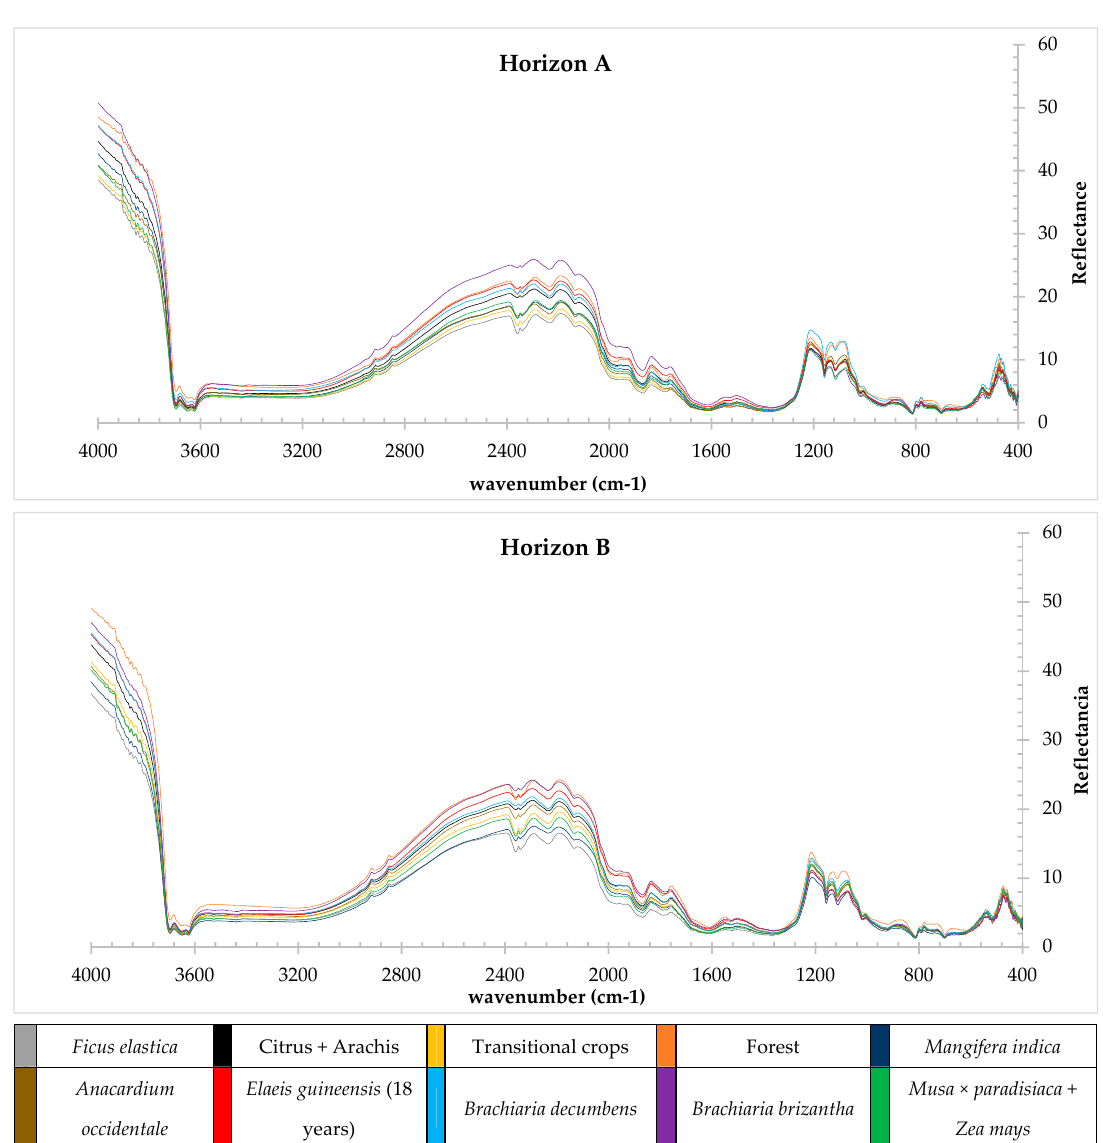
Figure 3. Spectral responses of soils studied in the MIR region horizon A and horizon B.